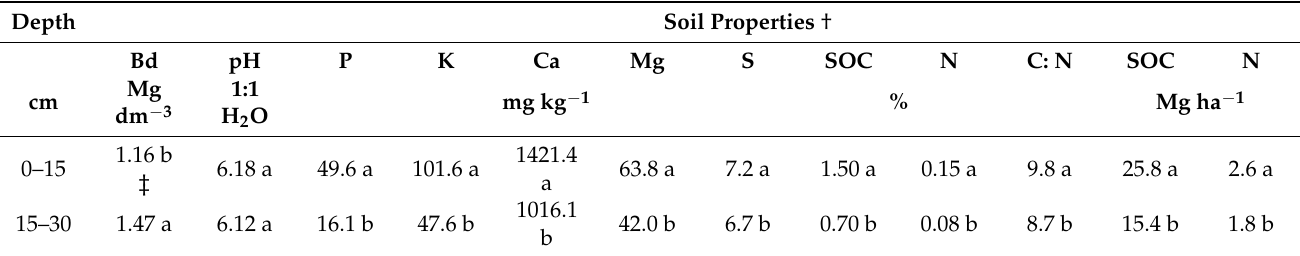
Table 3. Selected soil physical and chemical properties by depth in a 17-year agroforestry site in Fayetteville, AR (collected in 2016), averaged across tree species and fertilization treatments.